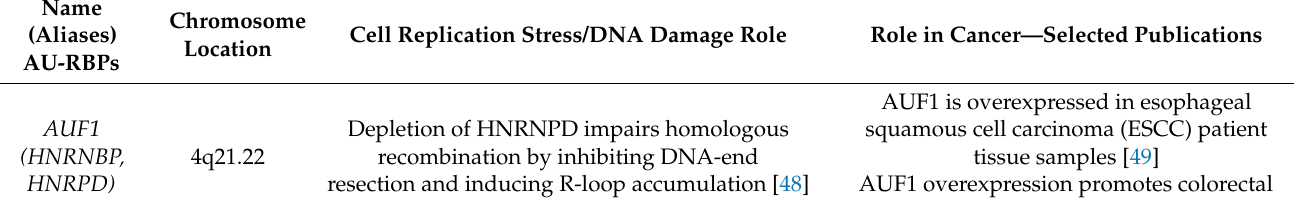
Table 1. Multi-faceted roles of AU-rich RNA binding proteins in maintaining genome